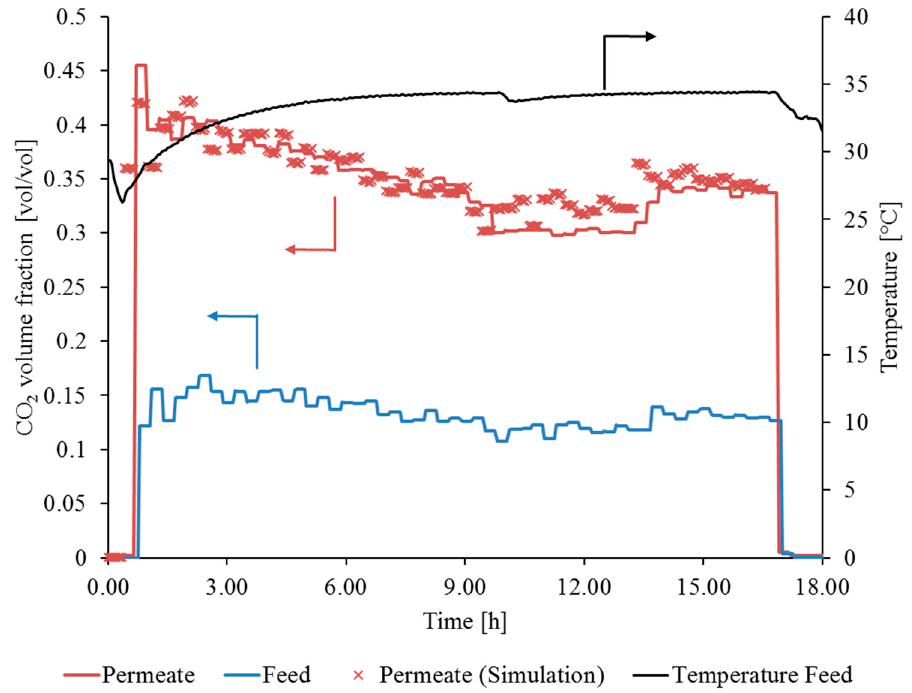
Figure 14. Stable operation of SILM in flue gas: y (cid:2890),(cid:2887)(cid:2899) . V N,F ~5.5 m 3 (STP)/h, p (cid:2926) ~125 mbar.